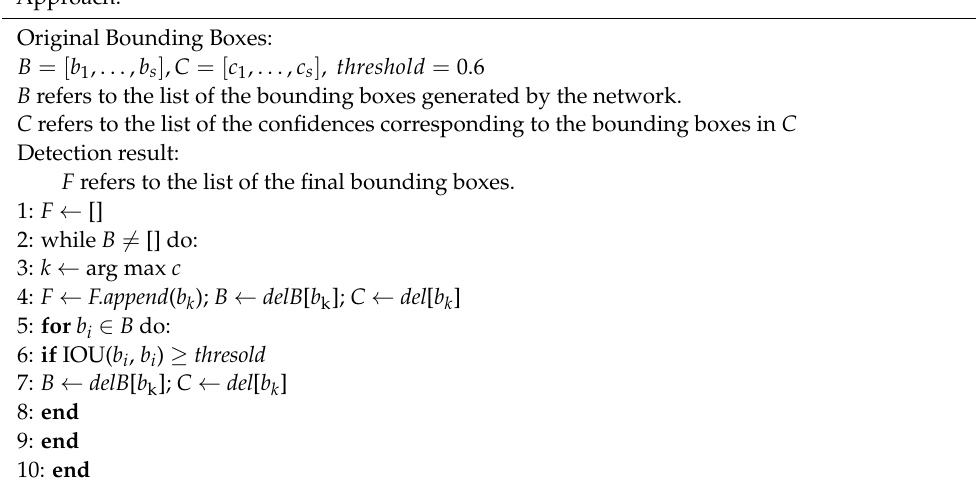
Algorithm 1. The pseudo code of Non-Maximum Suppression (NMS), NMS Algorithm for Our